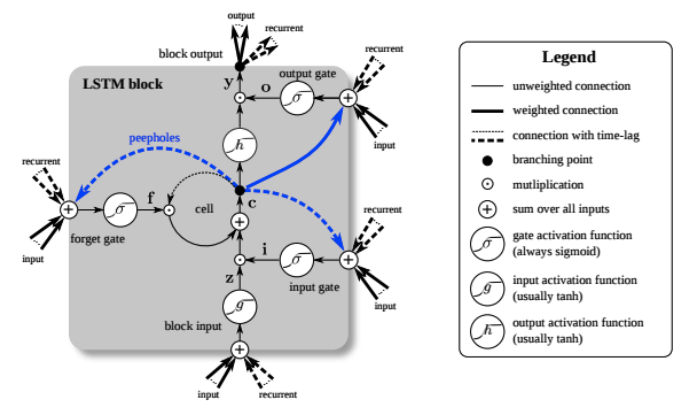
Figure 3. Training and test situation by raw dataset.